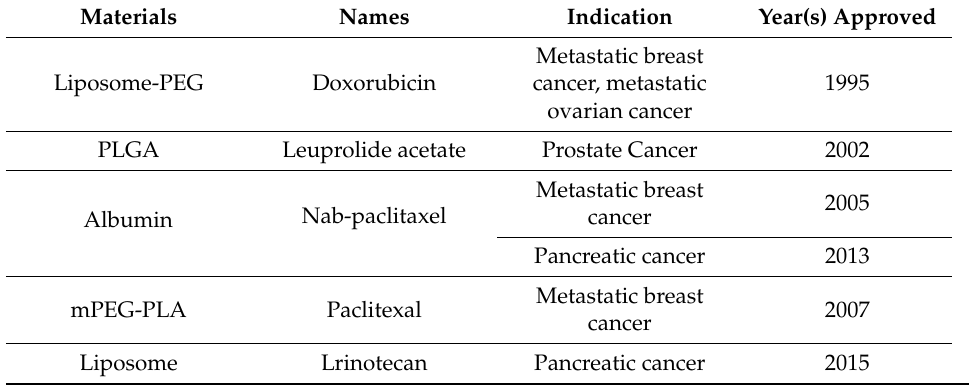
Table 4. FDA-approved nanomedicines for the treatment of cancer